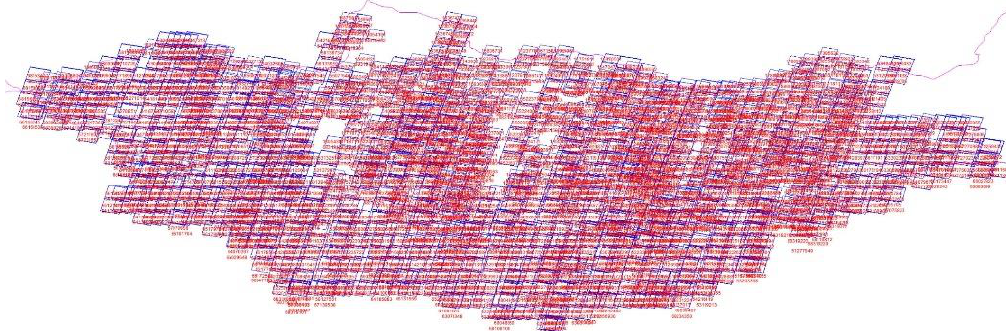
Figure 5: Overview of ZY-3 and GF-1 satellite image